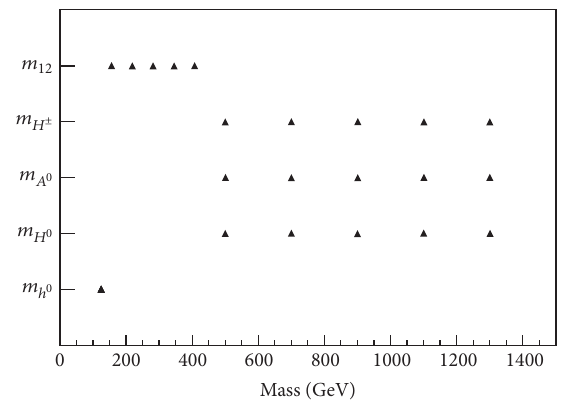
Figure 1: Higgs boson masses and the value of 𝑚 12 which respect physical requirements on model potential as well as experimental limits and observations on Higgs boson masses.